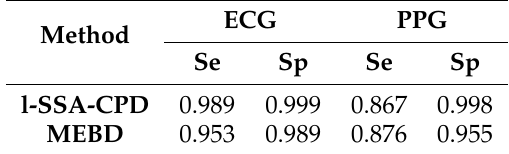
Table 3. Performance comparison of l-SSA-CPD (using D † 3